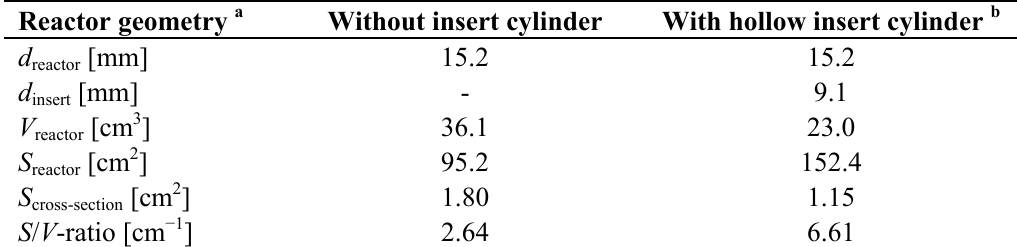
; diamonds), overall selectivity 1 ; crosses; see Scheme p2